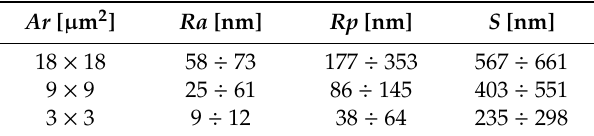
Table 2. The size of change (min ÷ max) of the roughness parameters a ff ected by osteoarthritis (N =